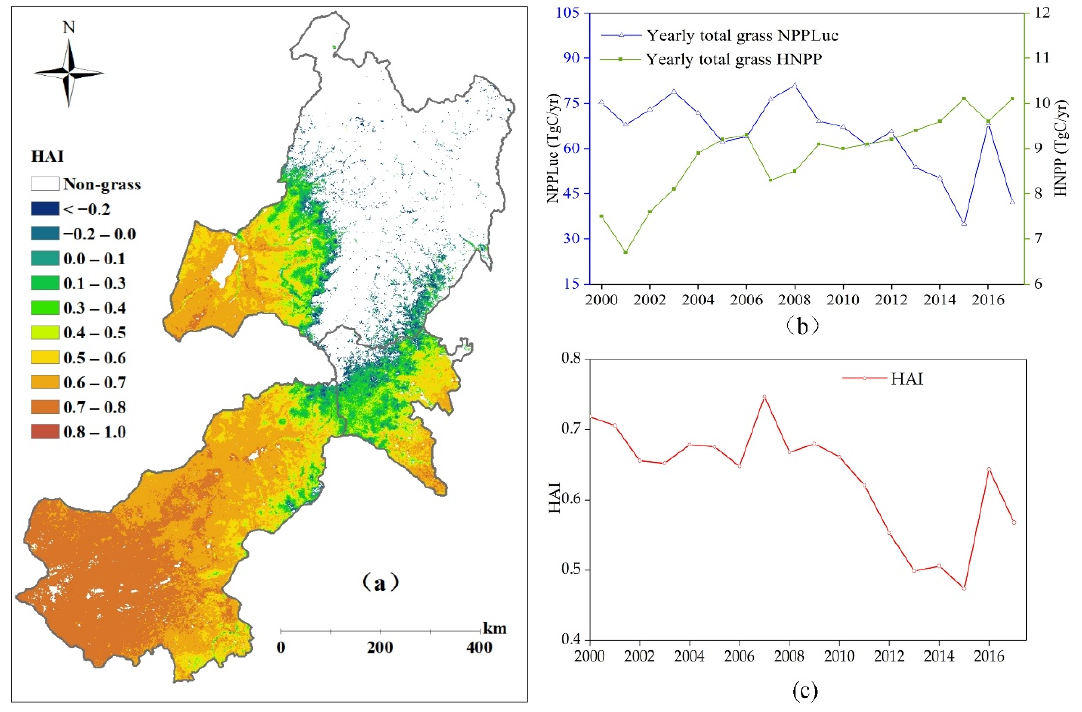
Figure 7. Spatial distribution of calculated multi-year averaged HAI ( a ), variation of total grasslands NPP Luc and HNPP ( b ), and variation of annual mean HAI ( c ) over the period of 2000 to 2017 in eastern Inner Mongolia.